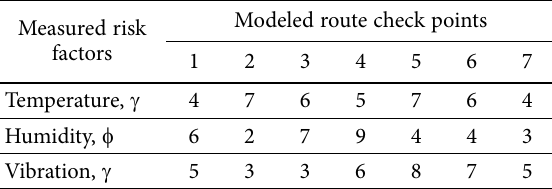
Fig. 7. Simulation of the expert system evaluation Table 7. Simulated expert system evaluations